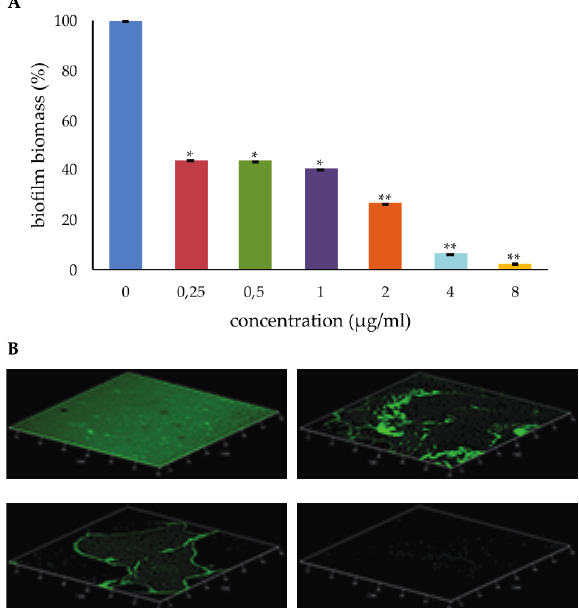
Figure 1. Inhibitory effect of pregnadiene-11-hydroxy-16α,17α-epoxy-3,20-dione-1 (PYED-1) on S. aureus biofilm formation. ( A ) Biofilms were quantified after crystal-violet staining. Values are presented as means ±SDs. Asterisks indicate statistically significant differences between the treated and untreated biofilms ( * p < 0.05 and ** p < 0.01, respectively). ( B ) Confocal laser scanning microscopy (CLSM) analysis of the biofilm formed by S. aureus ATCC 29213 in the absence (left upper panel) or presence of PYED-1, at the concentrations of 2 µ g / mL (right upper panel), 4 µ g / mL (left inferior panel), and 8 µ g / mL (right inferior